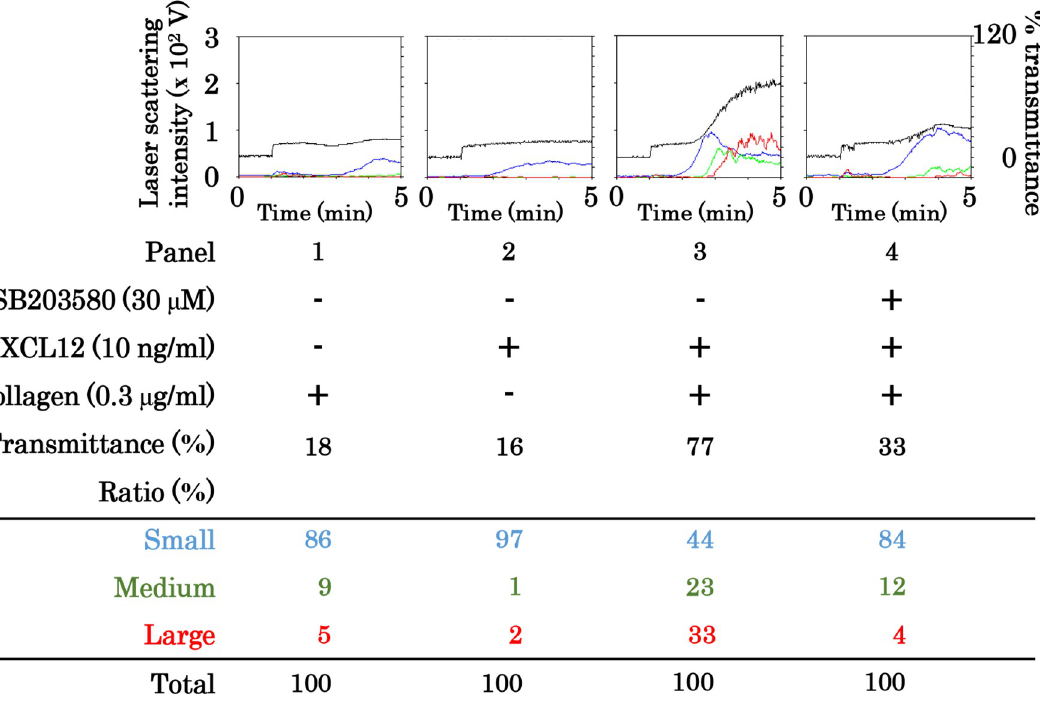
Fig 9. Effect of SB203580 on the platelet aggregation induced by simultaneous stimulation with collagen and CXCL12 in low doses. PRP was pretreated with 30 μ M of SB203580 or vehicle for 3 min and then simultaneously stimulated by 0.3 μ g/ml of collagen and 10 ng/ml of CXCL12 for 5 min. The reaction was terminated by the addition of ice-cold EDTA solution. The black line indicates the percentage of transmittance of each sample (isolated platelets recorded as 0%, and platelet-poor plasma recorded as 100%). The blue line indicates small aggregates (9–25 μ m); green line, medium aggregates (25–50 μ m); red line, large aggregates (50–70 μ m). The lower panel presents the distribution (%) of aggregated particle size as measured by laser-scattering. The representative results obtained from 5 healthy donors are